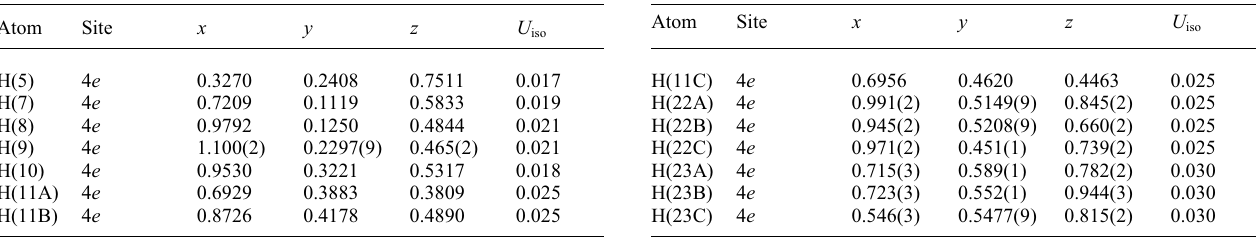
Table 2. Atomic coordinates and displacement parameters (in Å 2 )